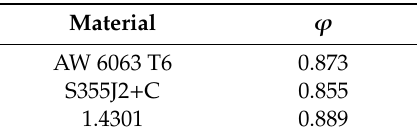
Table 3. Coe ffi cient ϕ .